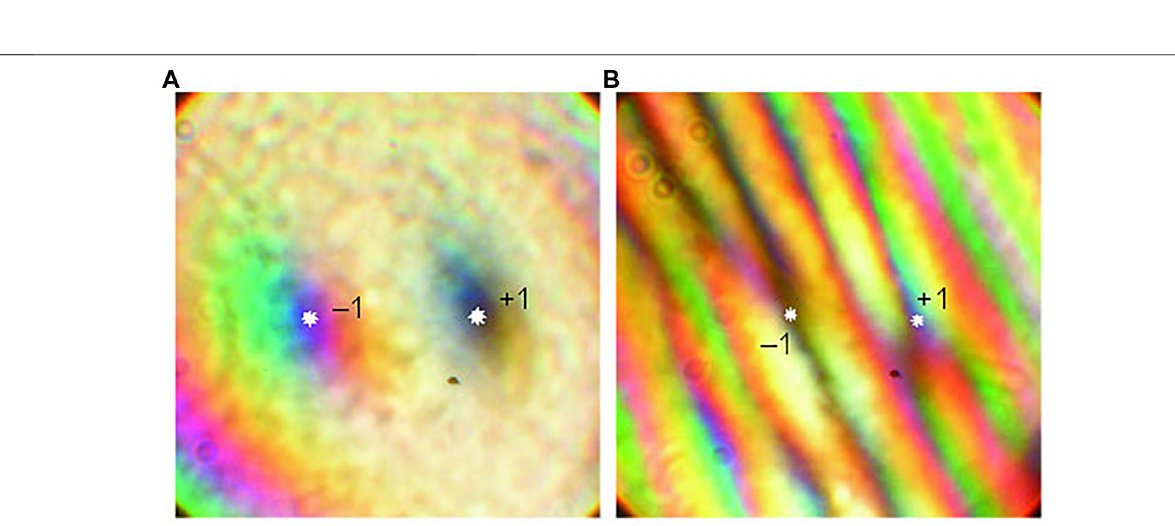
FIGURE12| Experimental arrangementforthe white-light OVanalysis: S,whitelightsource; C,condenser;D, diaphragm; O1,O2, O3and O4,objectives; P1and P2, polarizer and analyzer; BS1 and BS2, beam-splitting cubes; M1 and M2, mirrors; BC, singularity-generating object; CP, compensating plate; RF, Fresnel rhombus; W1 and W2, moving and stationary optical wedges; CCD, camera.